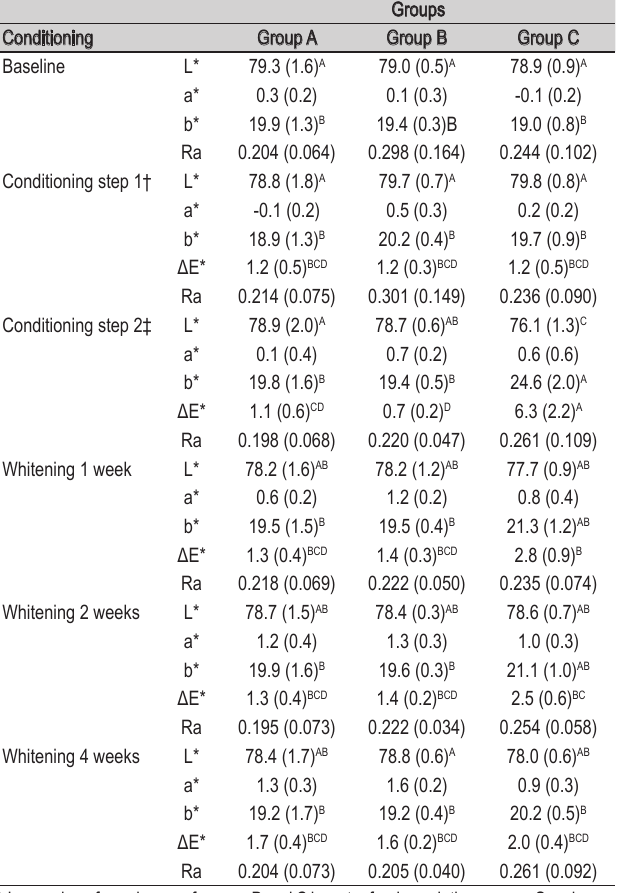
Table 1 - Results of L*, a*, b*, ΔE* and average surface roughness (Ra - µm) (mean and SD) after conditioning and